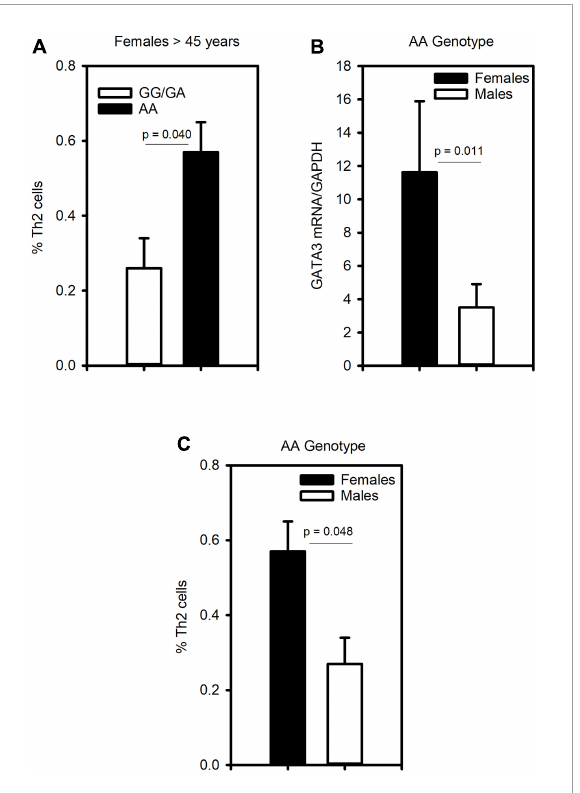
FIGURE4 The CRTh2 rs533116 G > A polymorphism is associated with increased type 2 inflammation. A subset of asthmatics were characterized for type 2 inflammation. (A) Influence of the AA genotype on the proportion of Th2 cells (CD4 + CRTh2 + /peripheral white blood cells) determined by flow cytometry in older females (45 years and older; AA = 3, GG/GA = 13). (B) Level of GATA3 mRNA from whole blood and (C) proportion of Th2 cells in older females ( n = 3) and males ( n = 3) carrying the AA genotype. Statistical differences determined Mann-Whitney U